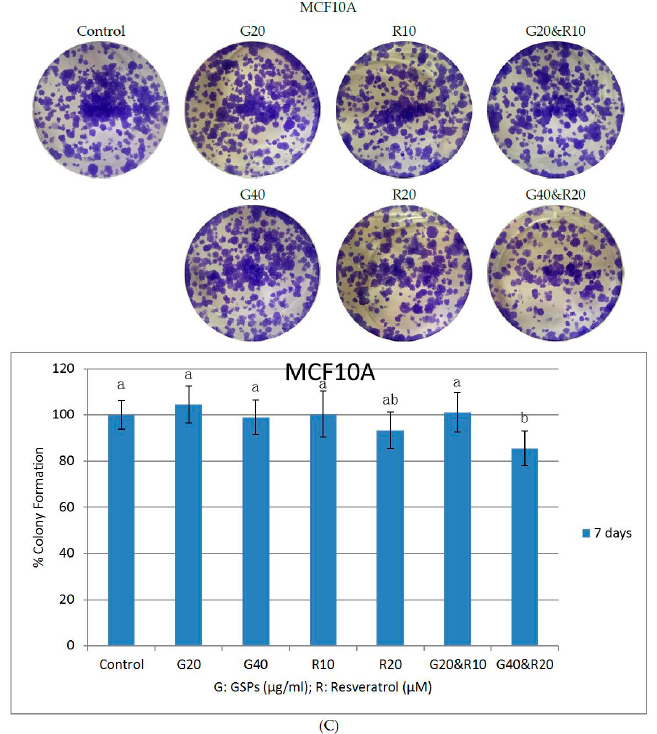
Figure 2. Clonogenic Assay. Inhibition of colony forming ability in MDA-MB-231 ( A ) and MCF-7 ( B ) human breast cancer cells as well as MCF10A ( C ) human mammary epithelial cells in seven days after treatment with GSPs (20, 40 μ g/ML), Res (10, 20 μ M), and their combinations (20 μ g/ML GSPs with 10 μ M Res, 40 μ g/ML GSPs with 20 μ M Res) as compared with the DMSO-treated control groups